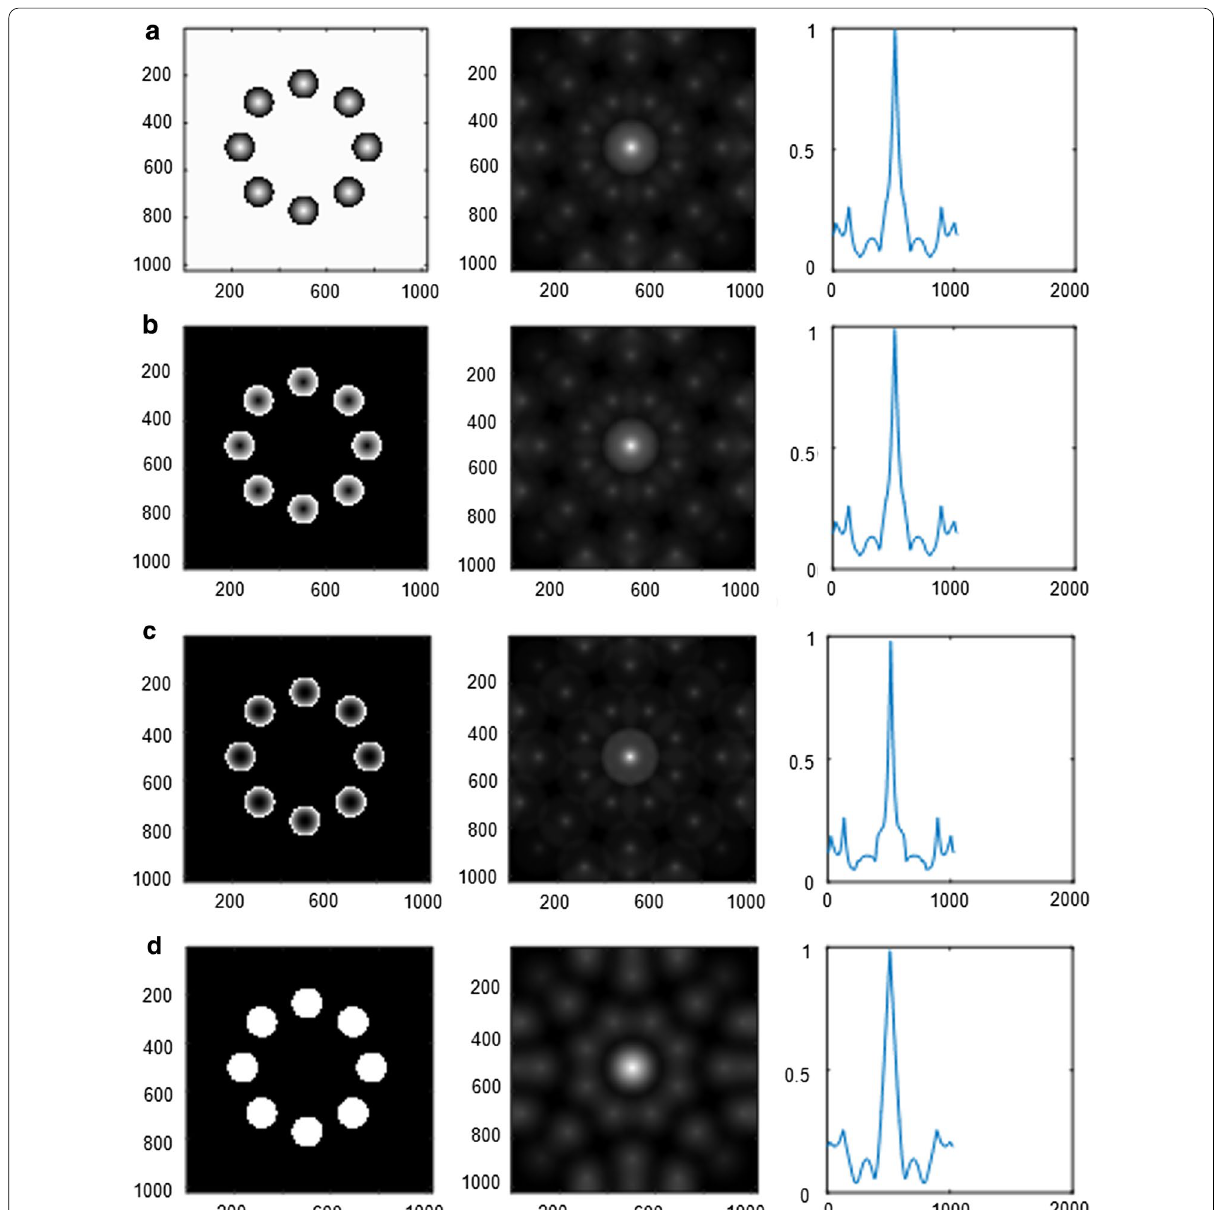
Fig. 6 a Autocorrelation image and the plot for the conic aperture. b Autocorrelation image and the plot for the linear aperture. c Autocorrelation image and the plot for the Quadratic aperture. d Autocorrelation image and the plot for the uniform circular